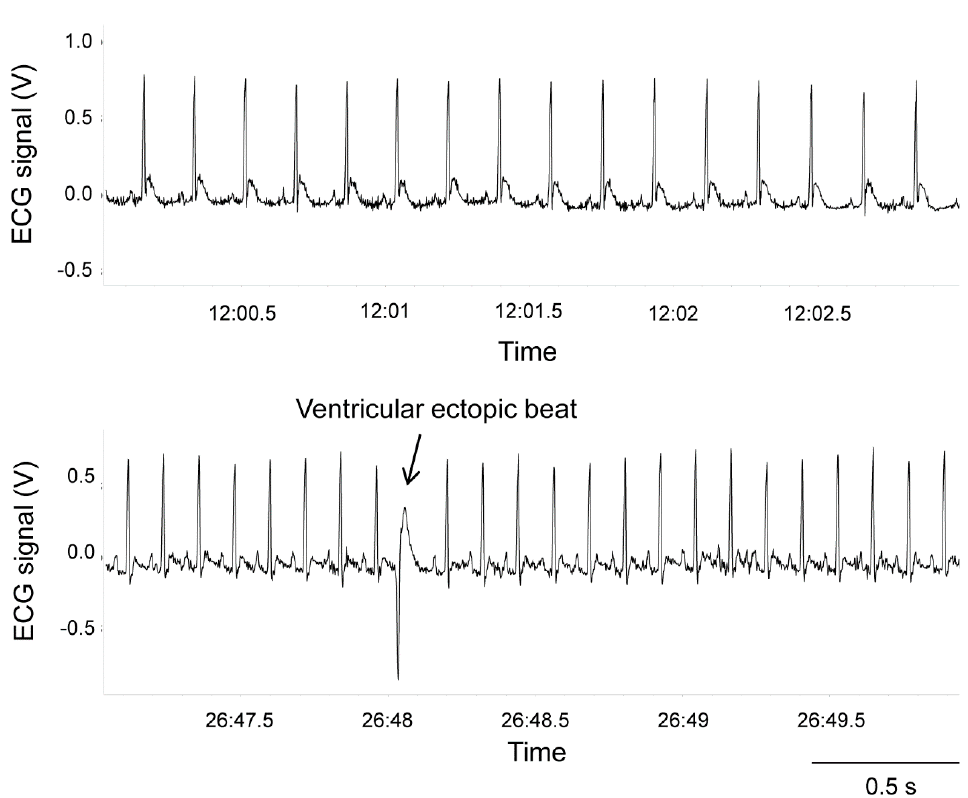
Figure 1. ECG tracings belonging to a representative wild-type Groningen rat with normal sinus rhythm (top panel) and isolated ventricular ectopic beat (bottom panel).